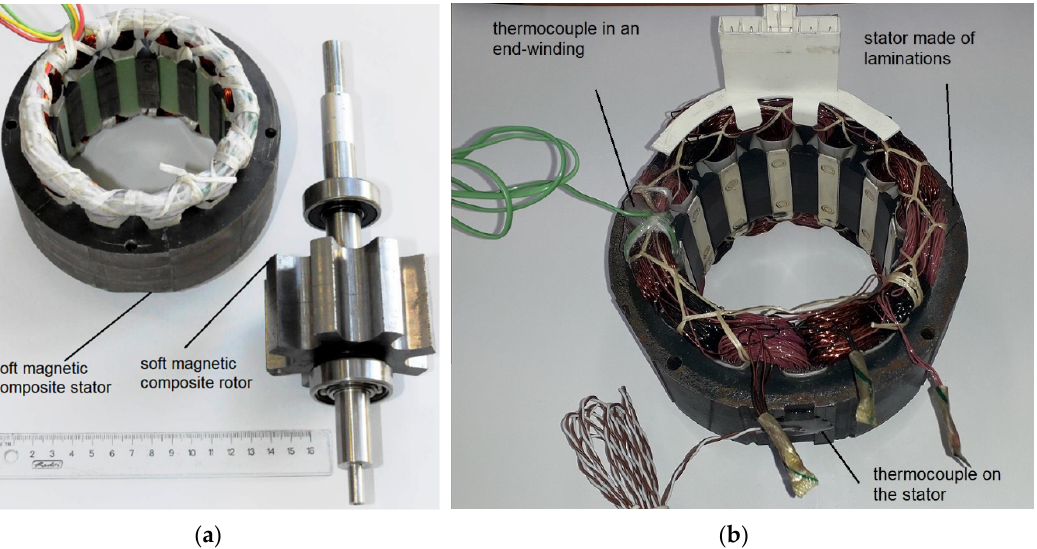
Figure 3. ( a ) Stator and rotor of the developed motor [36]; ( b ) stator of the modified Emerson Electric motor with thermocouples in an end winding and on the stator.